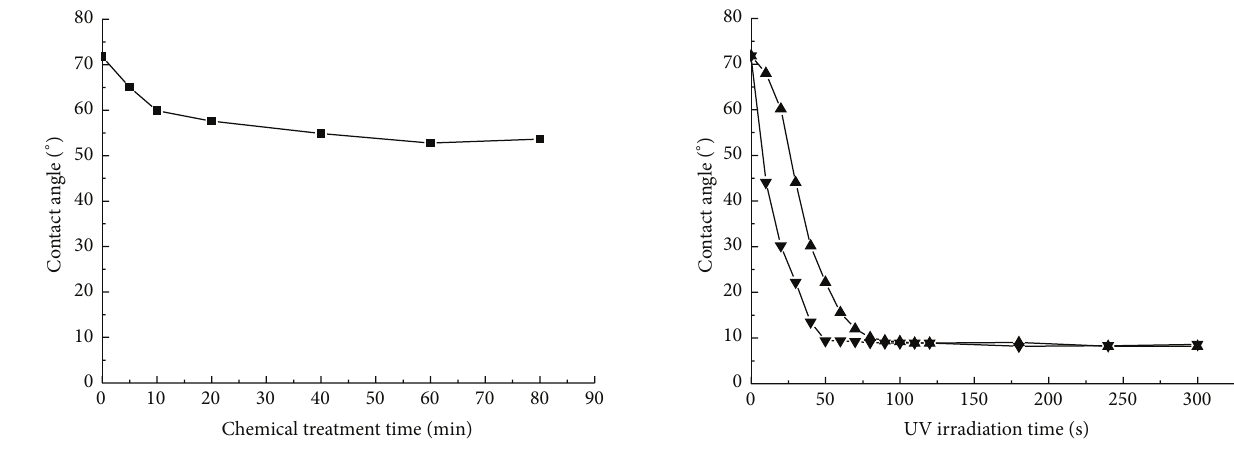
Figure 2: Contact angle curve of PLGA films after chemical treatment.